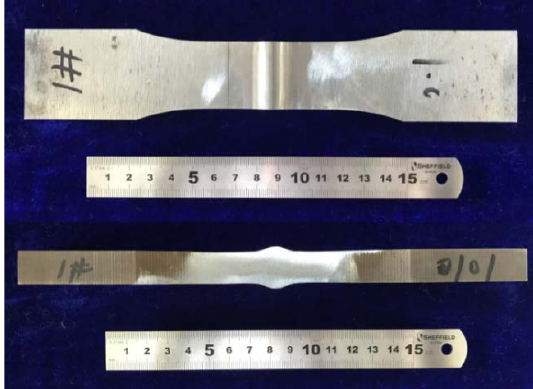
Figure 13. Macro shots of the designed welded joints.